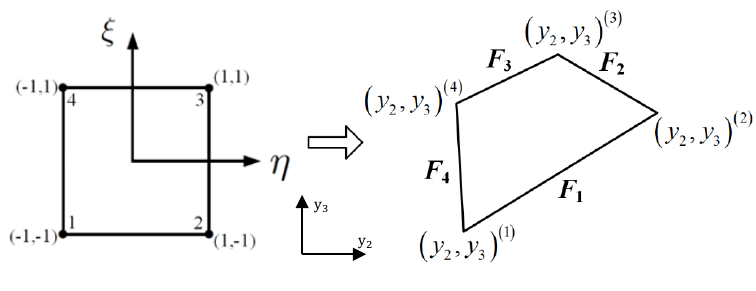
Figure 2. Parametric